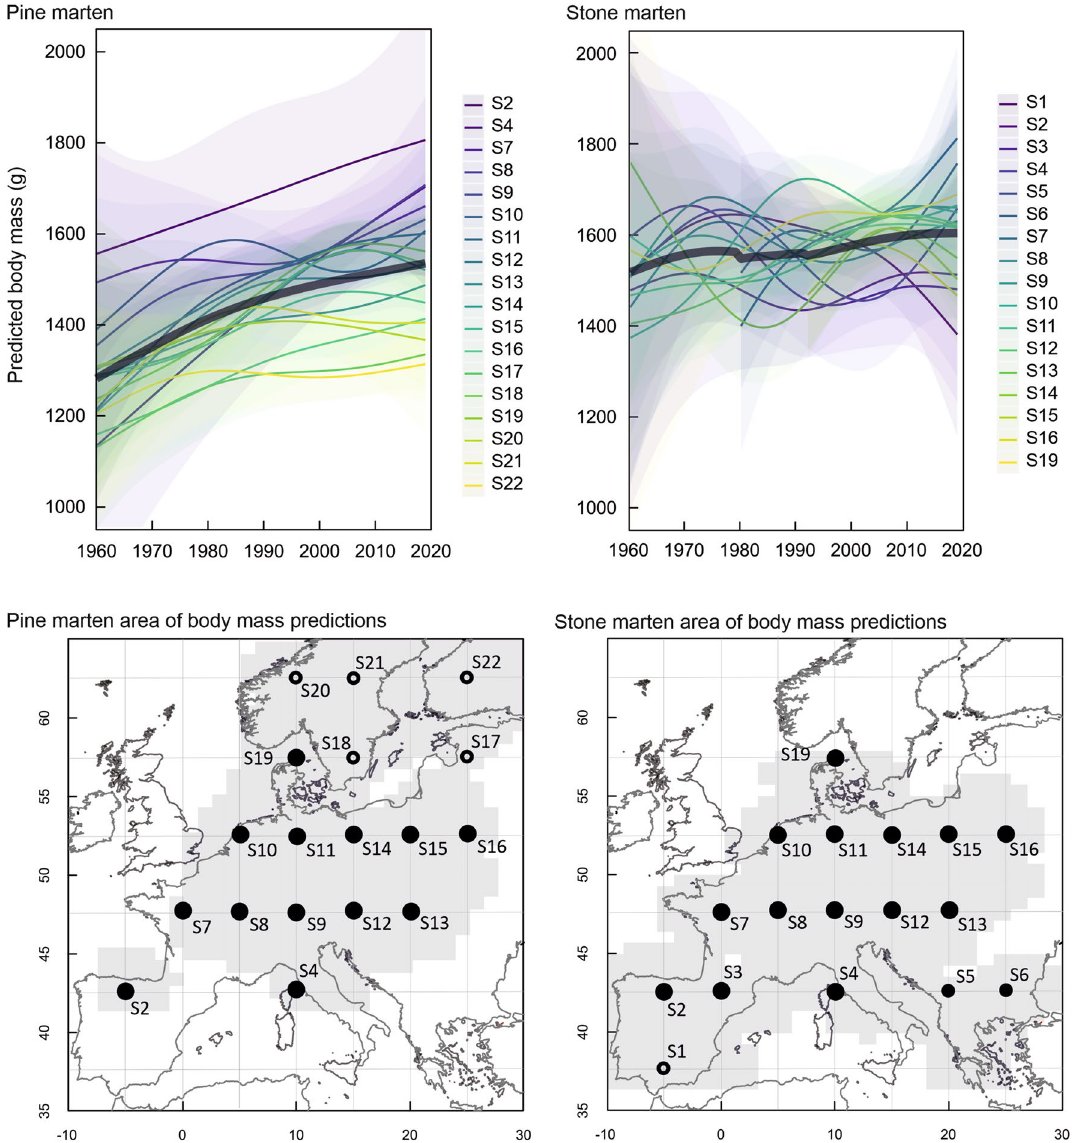
Figure 3. Body mass variation (with 95% confidence interval) of pine martens ( Martes martes ) and stone martens ( Martes foina ) in geographical gradient over time. Predictions are shown for males, predicted values for females are in Supplementary Table A2. Grey background on maps represents the geographic extent of GAM predictions of body masses based on collected data. Predicted body mass was visualized for sites of the geographical net with resolution 5° × 5° of latitude and longitude. Full dots represent sympatric sites while empty dots mean allopatric